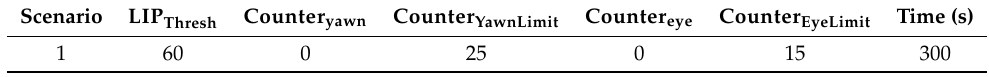
Table 4. Experimental parameters for scenario 1.